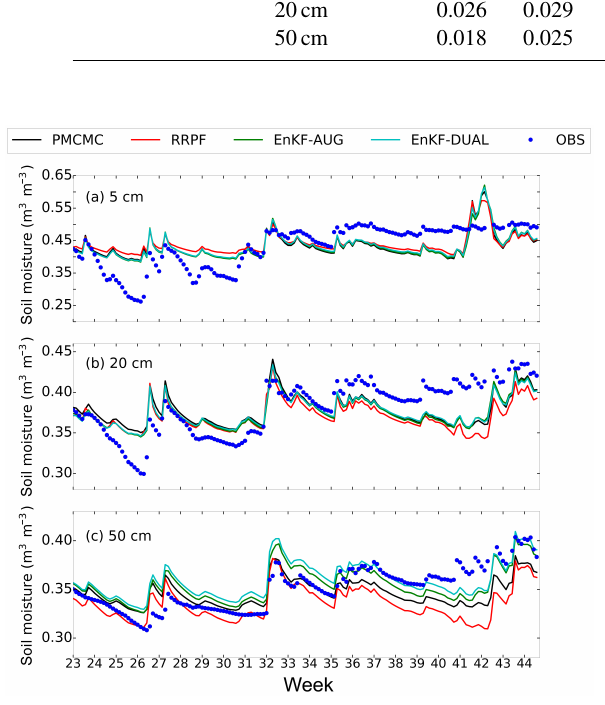
Figure 12. Trace plots of soil moisture contents simulated by CLM during the evaluation period at (a) 5cm, (b) 20cm, and (c) 50cm depths in the Rollesbroich site using the calibrated parameter values derived from PMCMC (black), RRPF (red), EnKF-AUG (green), and EnKF-DUAL (cyan). The measured moisture data are sepa- rately indicated in each panel with the solid blue dots. The first day of week 23 is 1 August 2012 and the last day of week 44 is 2 January